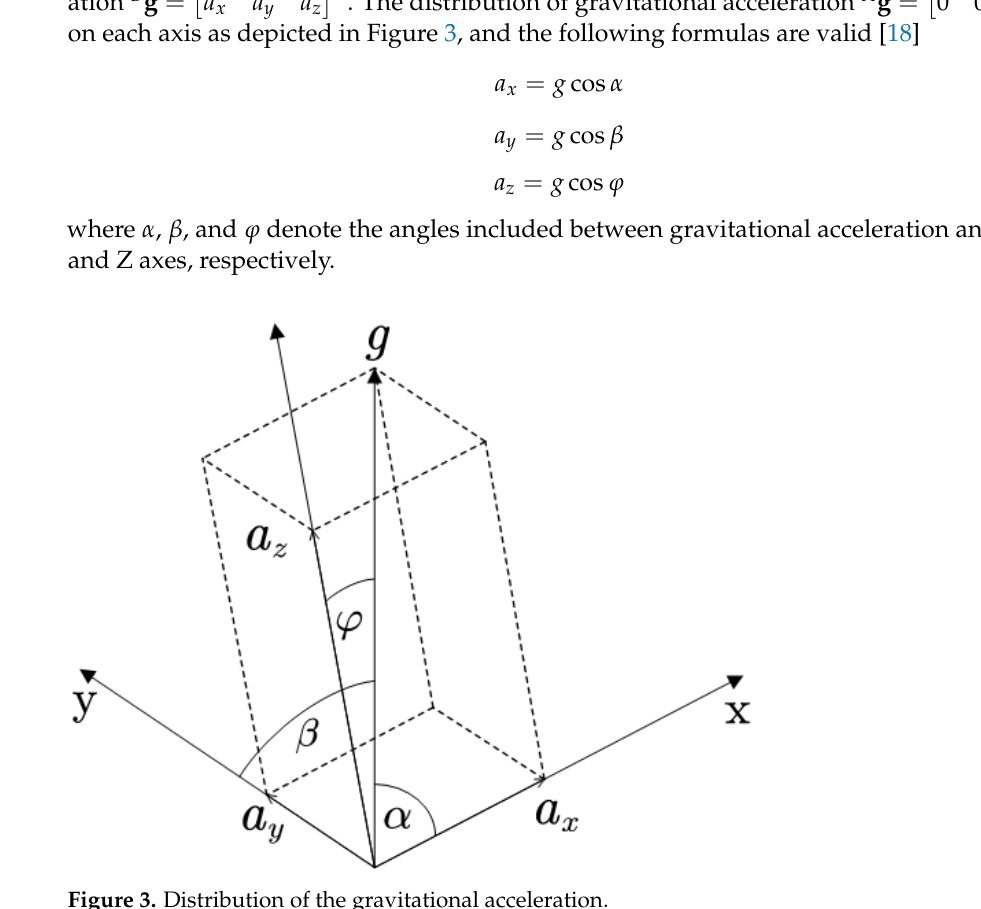
Figure 3. Distribution of the gravitational